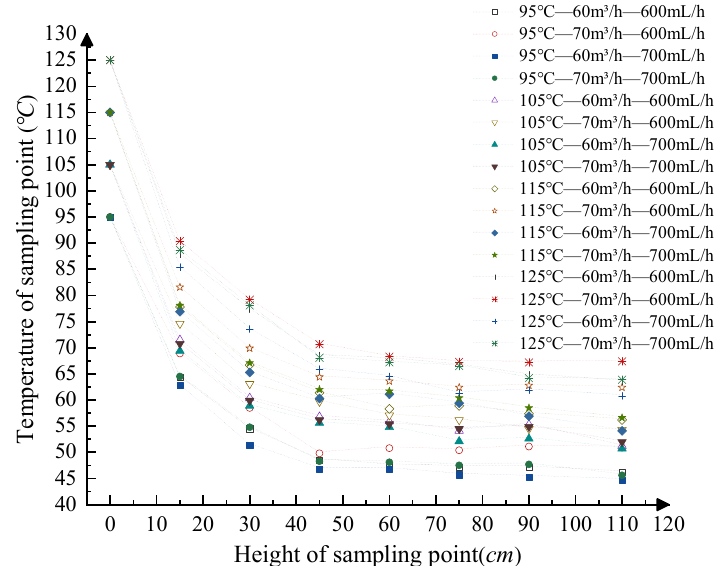
Figure 5. Sampling point temperature of each sampling cup under different test parameters.